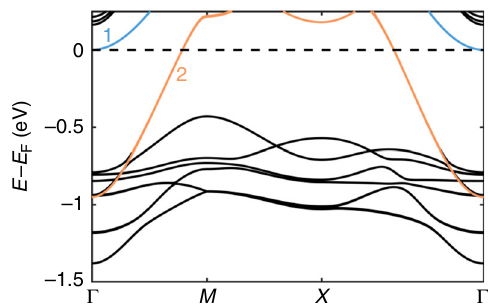
Fig. 4 LTO/STO band structure. Band structure calculated with DFT + U for three monolayers of LTO on STO (001). The blue and orange bands (labeled 1 and 2, respectively) are close enough to the Fermi level to contribute to the electrical transport. The black bands are too far away to contribute